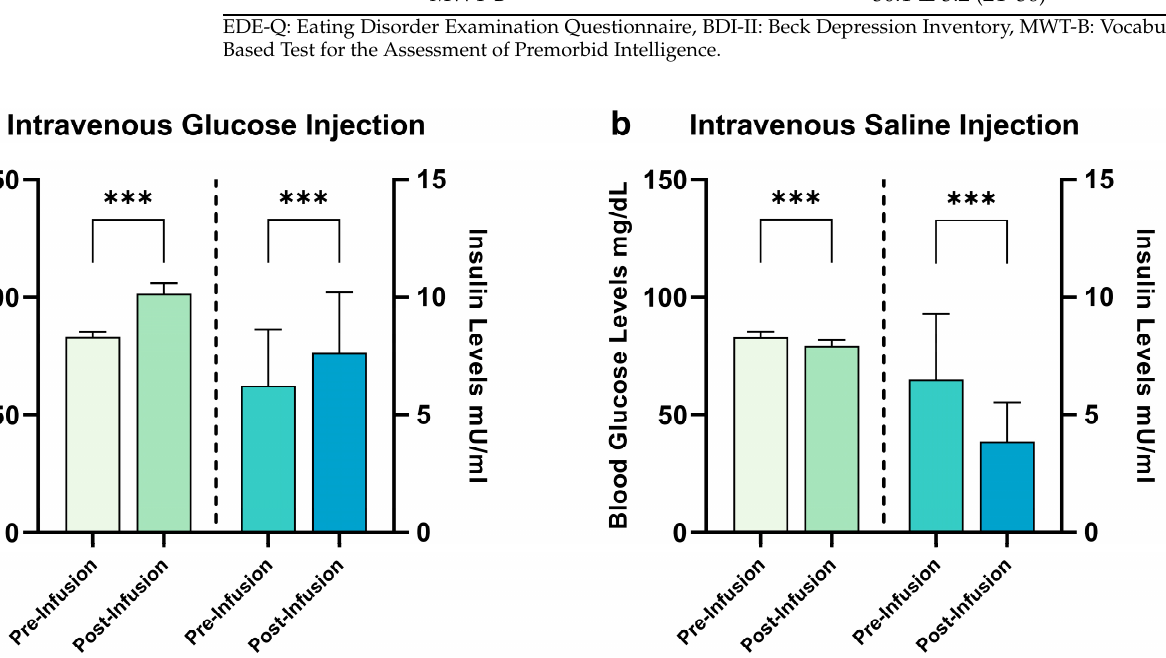
Figure 1. Changes in hormonal satiety parameters following G20 (( a ): glucose) injection and NaCl (( b ): saline) injection. During the glucose condition, we observed baseline blood glucose levels of